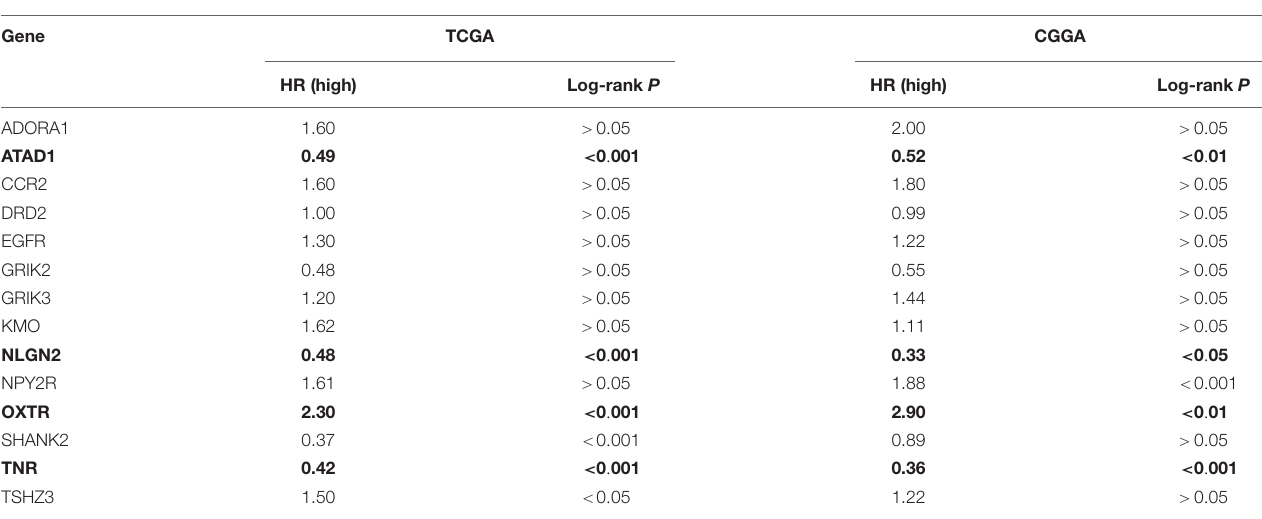
TABLE 2 | K–M survival analysis of 14 GSRS genes in TCGA and